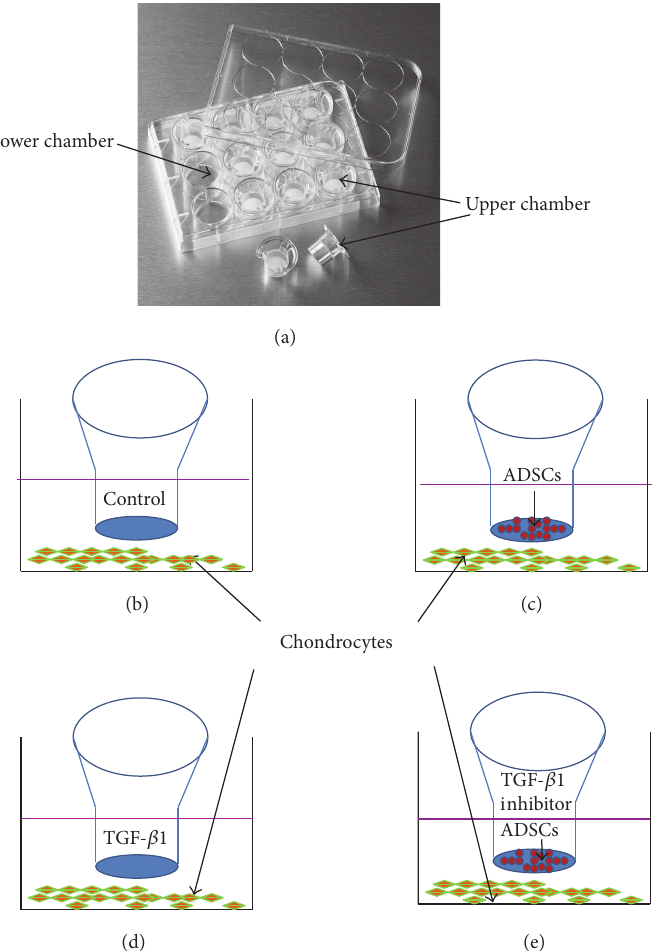
Figure 1: The experimental model. (a) The picture of transwell chamber. ((b)–(e)) The schematic diagram of the four groups, respectively, for chondrocytes cultured in normal culture medium (b), chondrocytes cocultured with ADSCs together (c), chondrocytes cultured with TGF- 𝛽 1-containing medium (d), and chondrocytes cocultured with both ADSCs and TGF- 𝛽 1 inhibitor